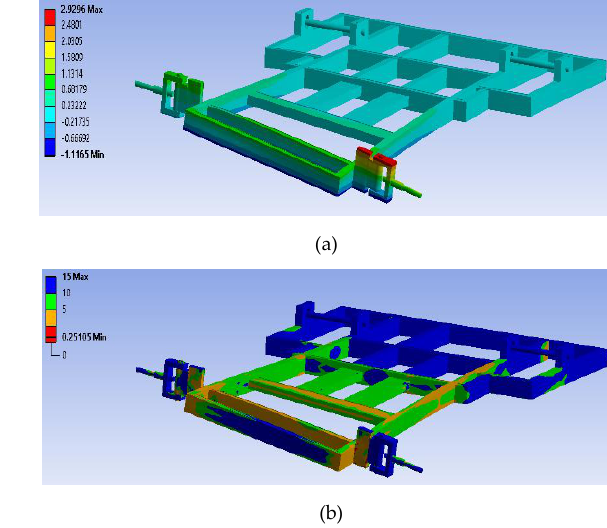
Figure 18: Deformation (a) and safety factor (b) of the seventh variation of chassis simulation